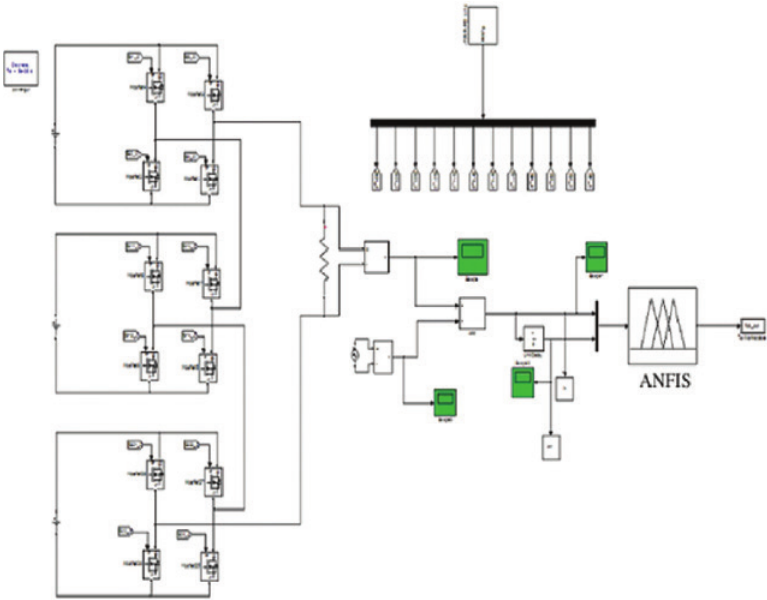
Figure 4: MATLAB Model of the Proposed